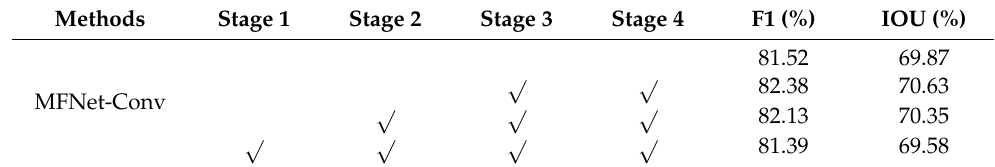
Table 7. Results of ablation experiments using MFAM at different stages of the encoder.